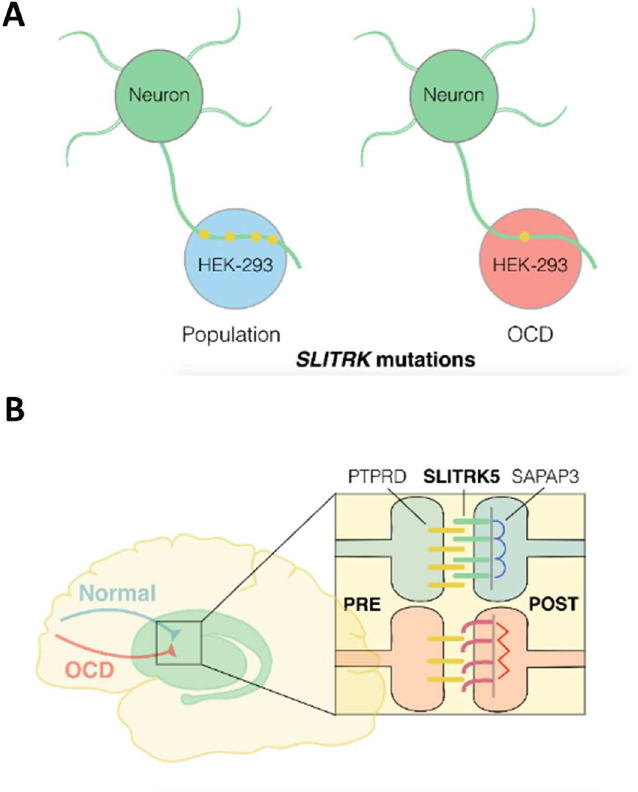
Fig 5. Genetic risk factors in OCD converge on corticostriatal synapse function. (A) Schematicof functionaleffects of OCD versus 1000 Genomes population control RNM’s. All control RNM’s supported synaptogenesis similar to WT Slitrk5 when expressedin HEK-293 cells (blue) while all OCD RNM’s impaired synaptogenesis (red). (B) Schematicof corticostriatal synaptic dysfunction identifiedin genetic studies of OCD. PTPRD is associatedwith OCD in GWAS and both SLITRK5 and SAPAP3 cause an OCD-like syndromein knockout mice and contain rare OCD-associated mutations.